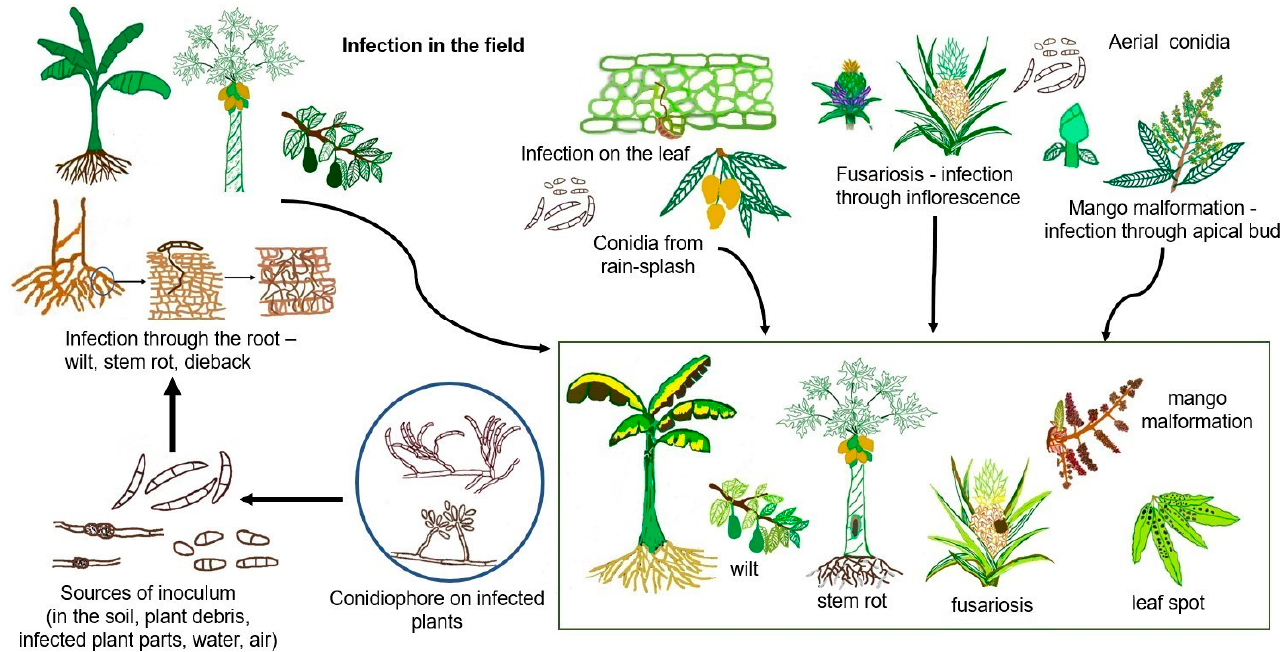
Figure 1. Disease cycle of Fusarium diseases in the field on major tropical fruit crops. Fusarium oxysporum and F. solani are the most commonly associated with tropical fruit crops. Both species mainly inhabit the soil and are widespread throughout tropical regions. The most well-known disease associated with these species is vascular wilt [7]. Currently, both species are species complexes, comprised of numerous cryptic species or phylogenetically similar species. In addition to F. oxysporum and F. solani, F. incarnatum (syn. F. semitectum ), F. proliferatum , and F. verticilliodes are also commonly reported to be associated with major tropical